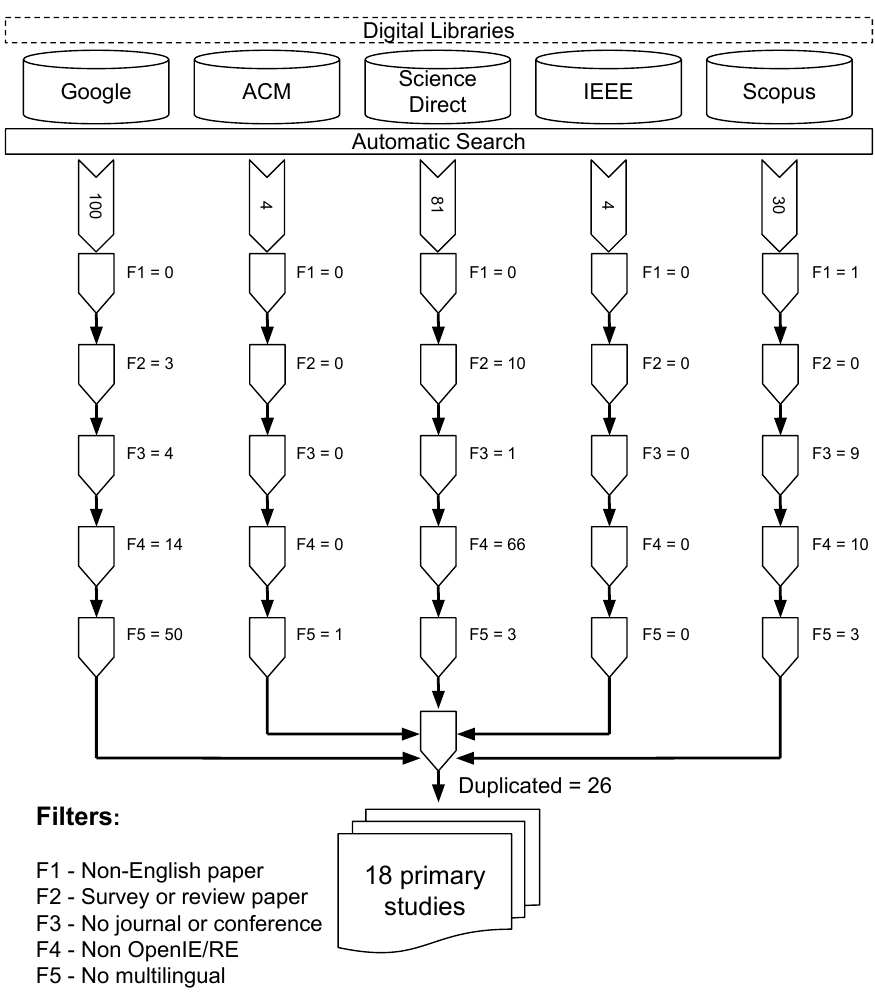
Figure 1. Filters applied in the SMS process. (Authors’